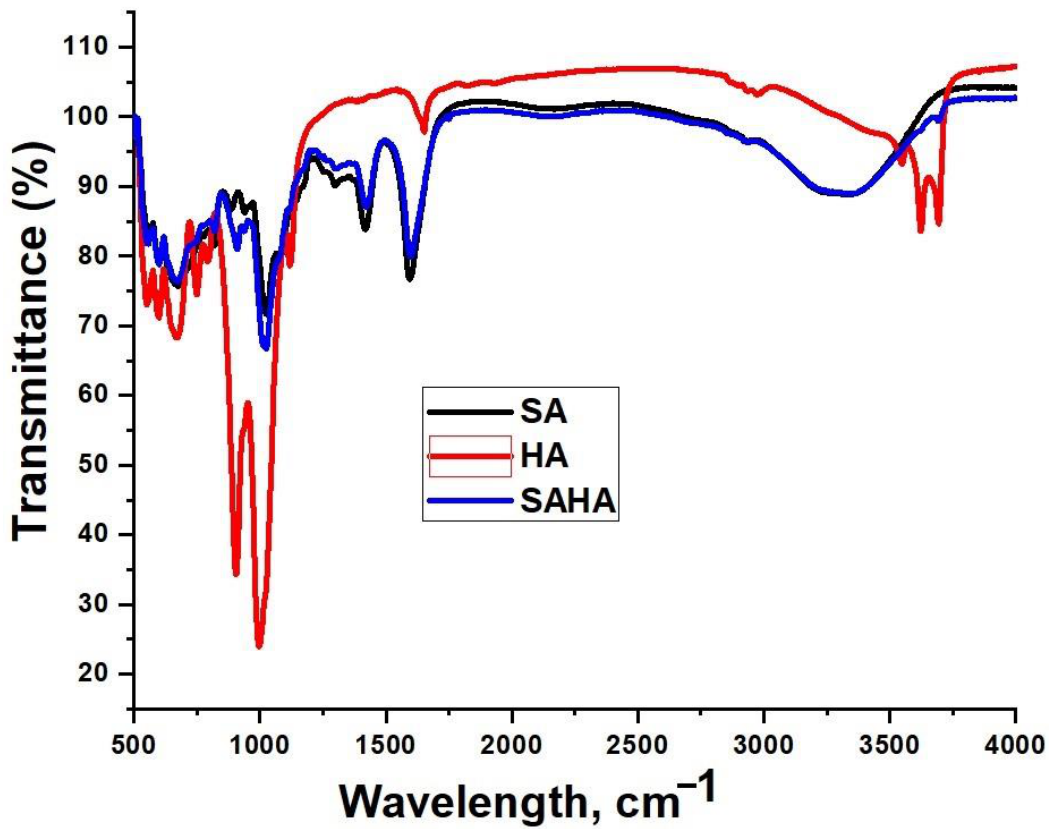
Figure 6. FT-IR spectra of the HA, SA, and SAHA aerogels.